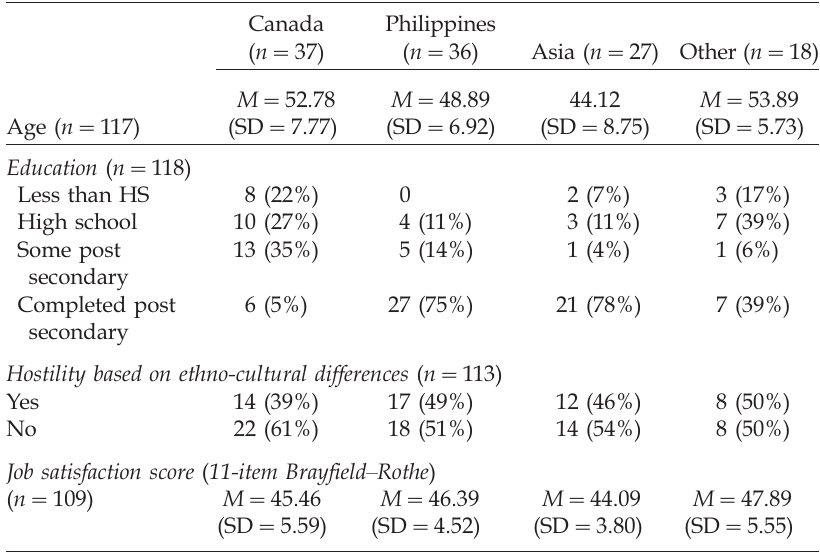
Table 2. Differences in worker characteristics by country of origin Canada ( n (cid:2) 37)